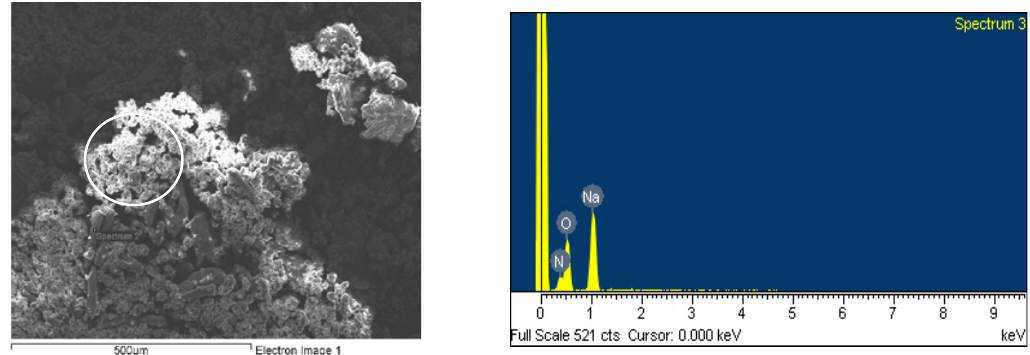
Figure 12. SEM micrograph and EDS spectrum of solids crystallized from Test A.